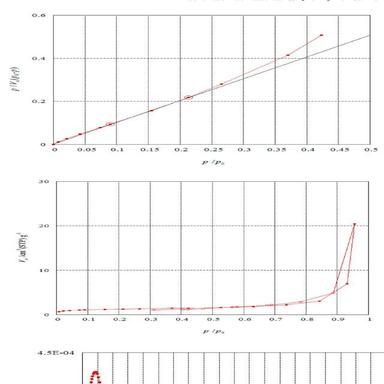
BET-plot (a), adsorption desorption isotherms (b) and pore size distribution (c) of SiO2@C nanocomposite (SC1).